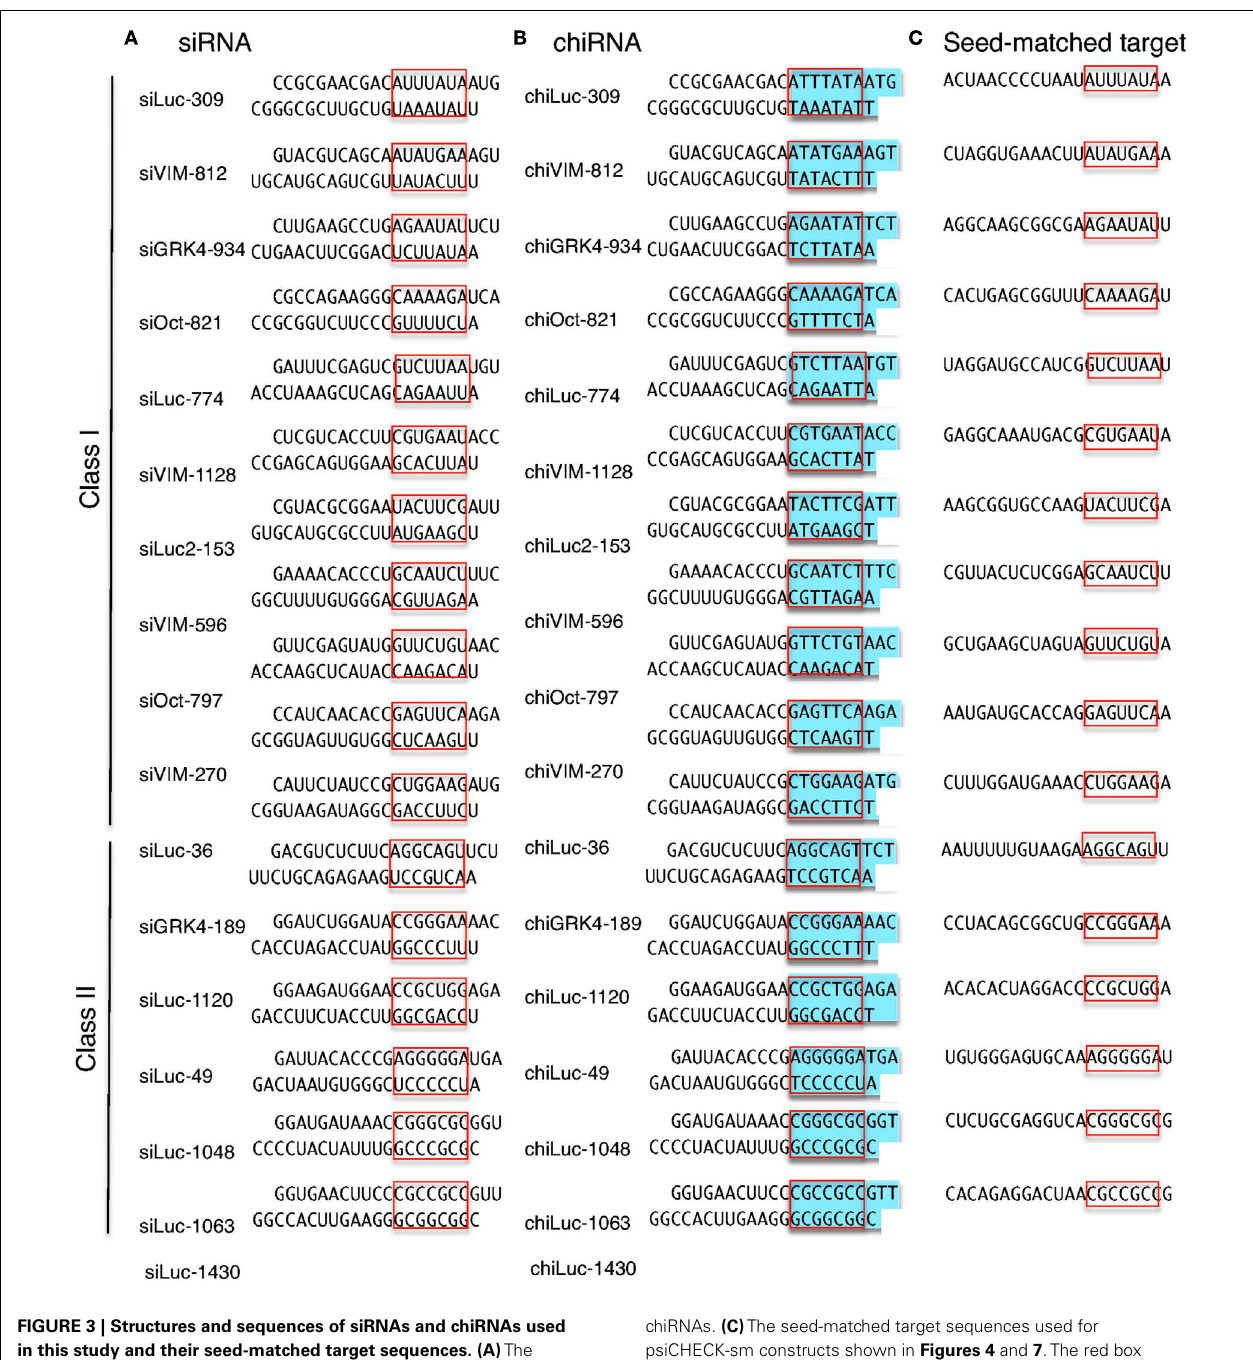
chiRNAs. (C) The seed-matched target sequences used for psiCHECK-sm constructs shown in Figures 4 and 7 .The red box indicates the seed region, and blue indicates the DNA-substituted regions within the